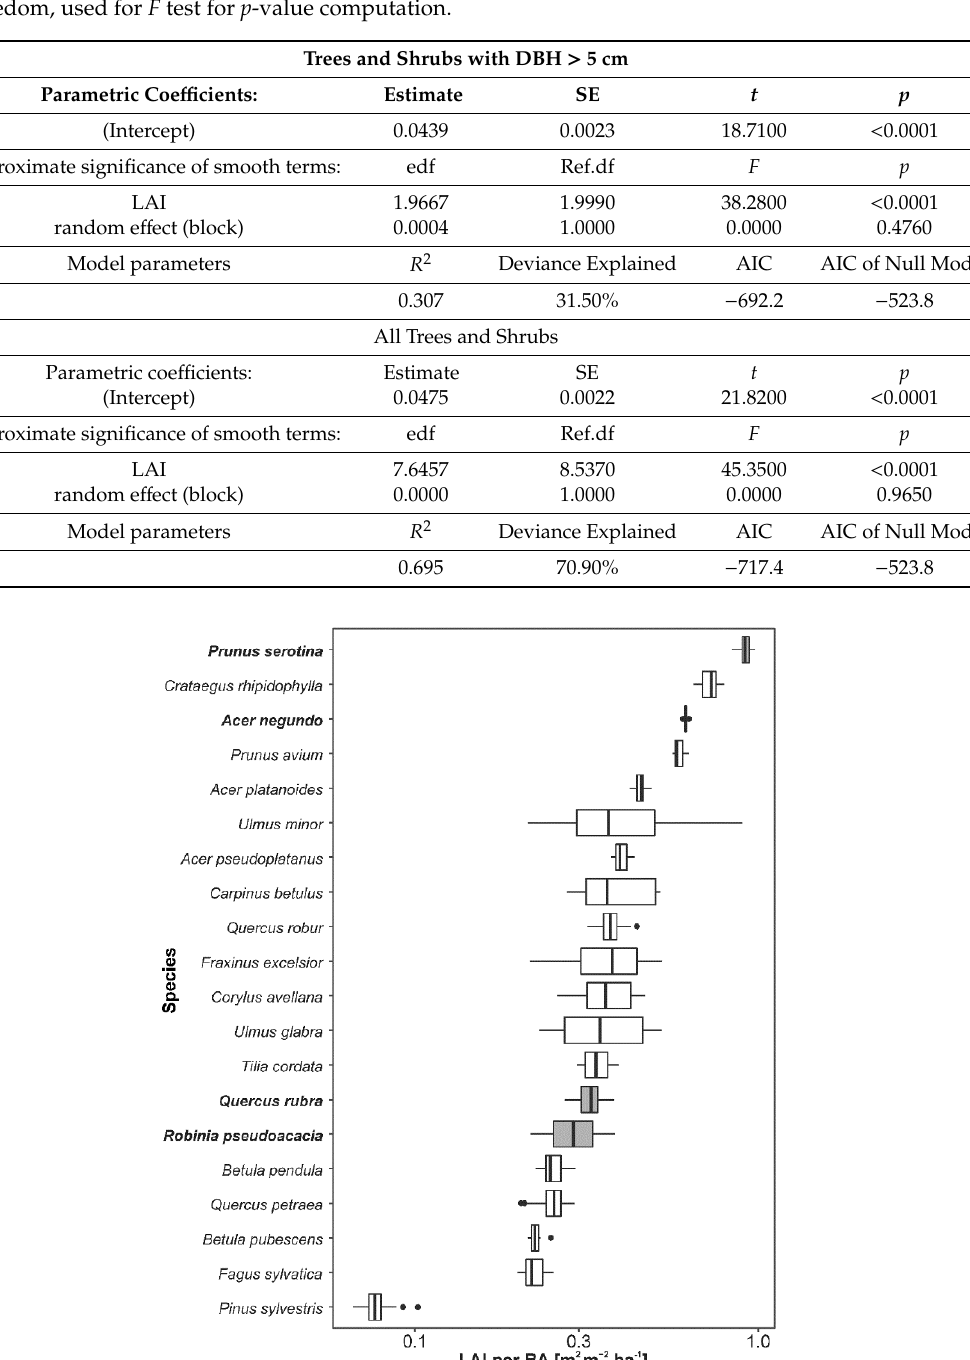
Figure 3. Distributions of LAI to BA ratio (relation of leaf area to basal area; m 2 of foliage per m 2 ha − 1 of basal area) for tree species (alien species bolded and with grey boxes) including only specimens with DBH > 5 cm. Only species occurring in at least five plots were presented. Boxplots indicate the first and third quartiles, the line inside box indicates the median, and whiskers indicate the minimum, and maximum without outstanding observations (>1.5 interquartile range).